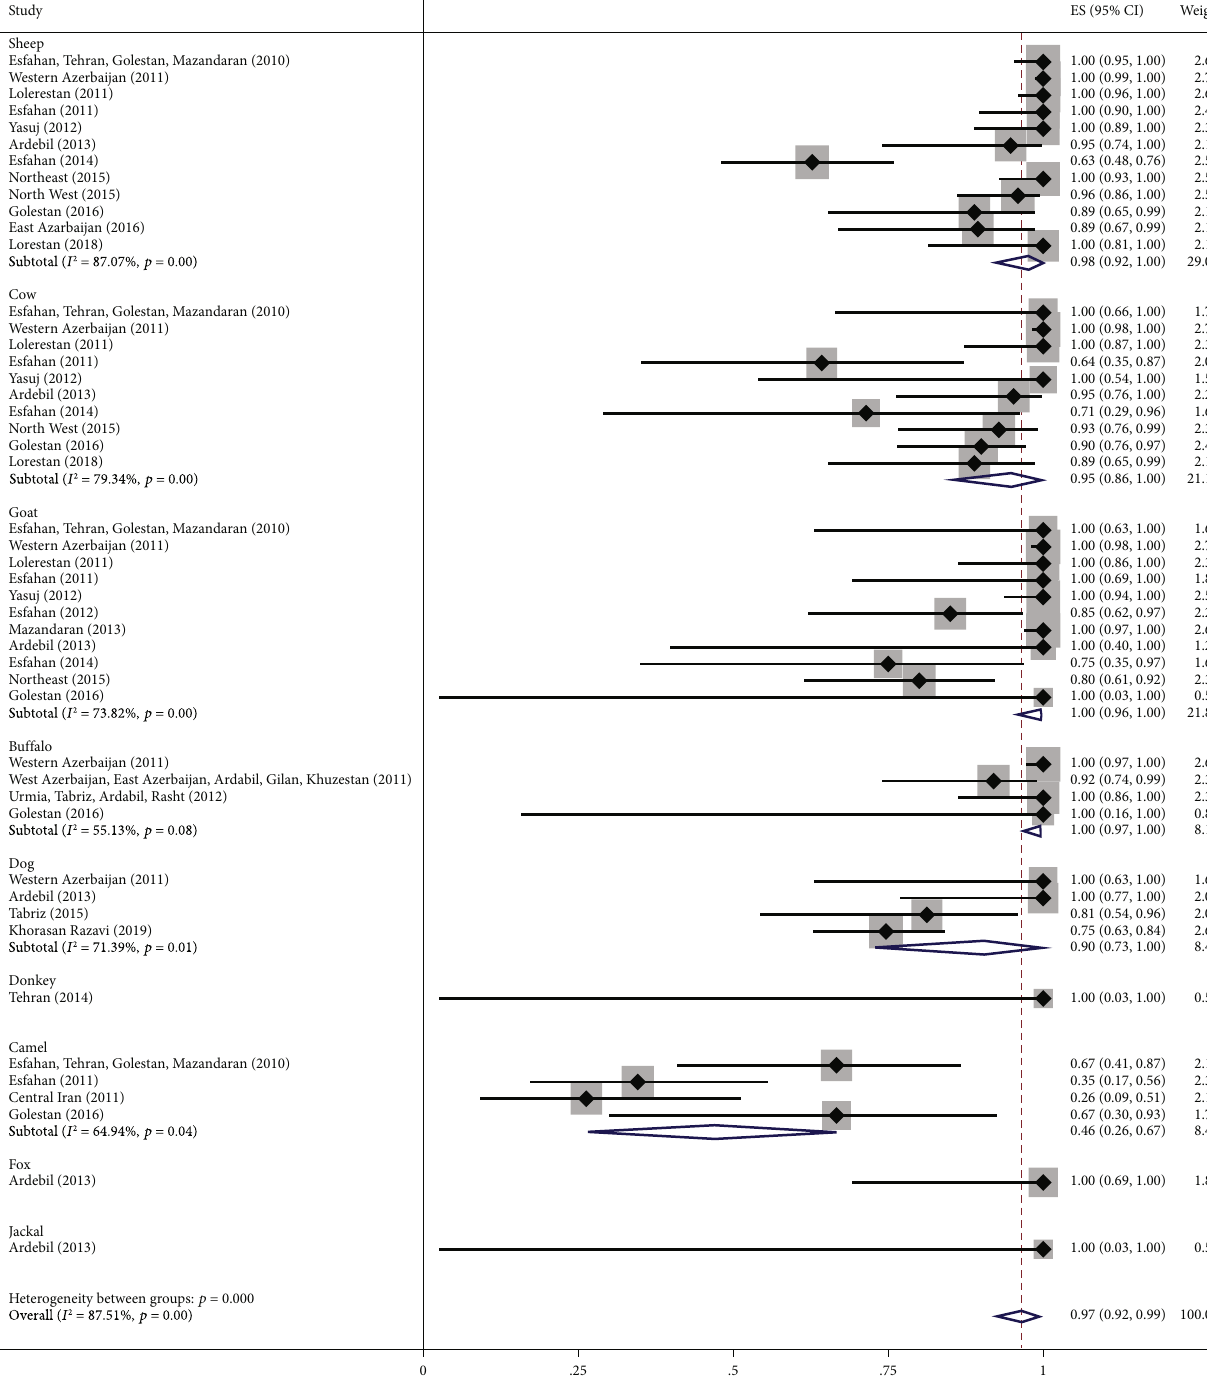
Figure 9: Forest plot of subgroup analysis of studies on cystic echinococcosis G